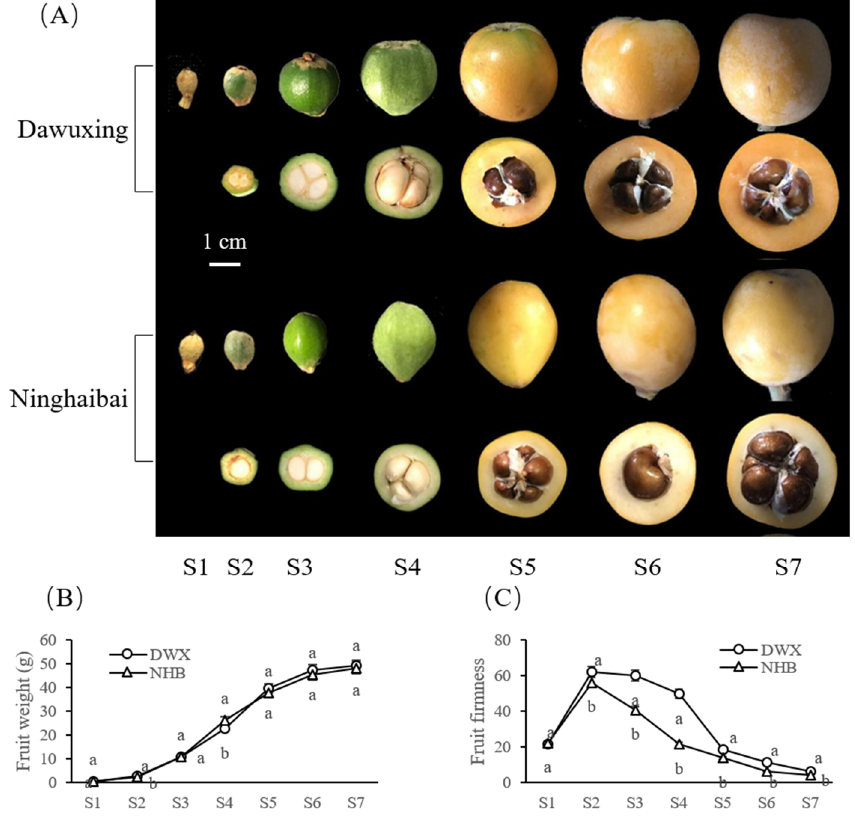
Figure 1. Fruit phenotype ( A ), weight ( B ), and firmness ( C ) changes during fruit development and ripening of the Dawuxing and Ninghaibai loquat. The x axis represents seven different developmental stages of loquat fruit: 50, 110, 130, 150, 160, 170, and 180 days after full bloom (DAFB). The transverse sections of fruits corresponding to these developmental stages are shown in ( A ). Scale bar represents 1 cm. Values are means ± SD of three biological replicates. Variance analysis was carried out independently for each of the seven developmental stages studied. The different lowercase letters in the line charts indicate significant differences ( p < 0.05).